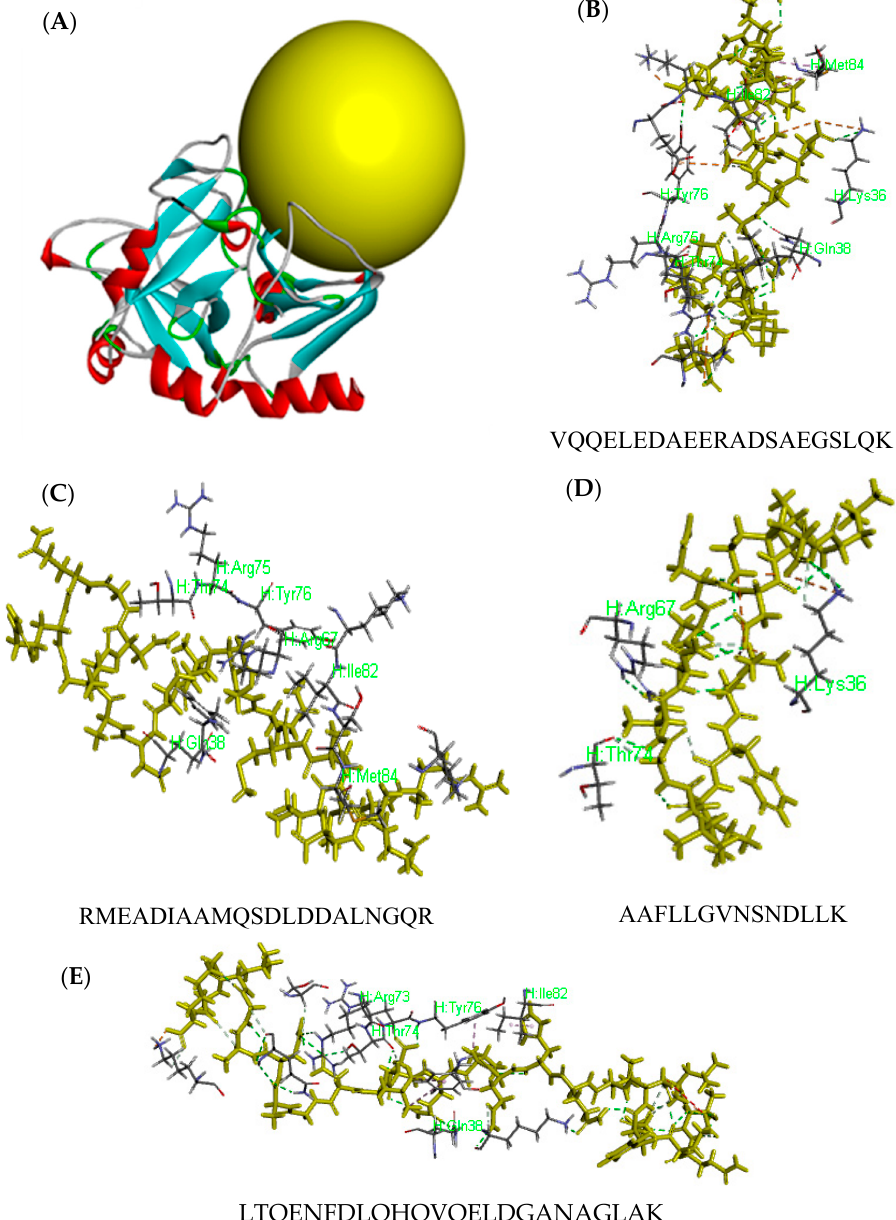
Figure 3. Molecular docking for the interactions of peptide against Thrombin. Molecular structure of thrombin from PDB database ( A ), the yellow sphere showed the docking position; VQQELEDAEERADSAEGSLQK ( B ), RMEADIAAMQSDLDDALNGQR ( C ), AAFLLGVNSNDLLK ( D ), and LTQENFDLQHQVQELDGANAGLAK ( E ). The peptides were marked with yellow sticks; the other sticks are the interactive amino acids of